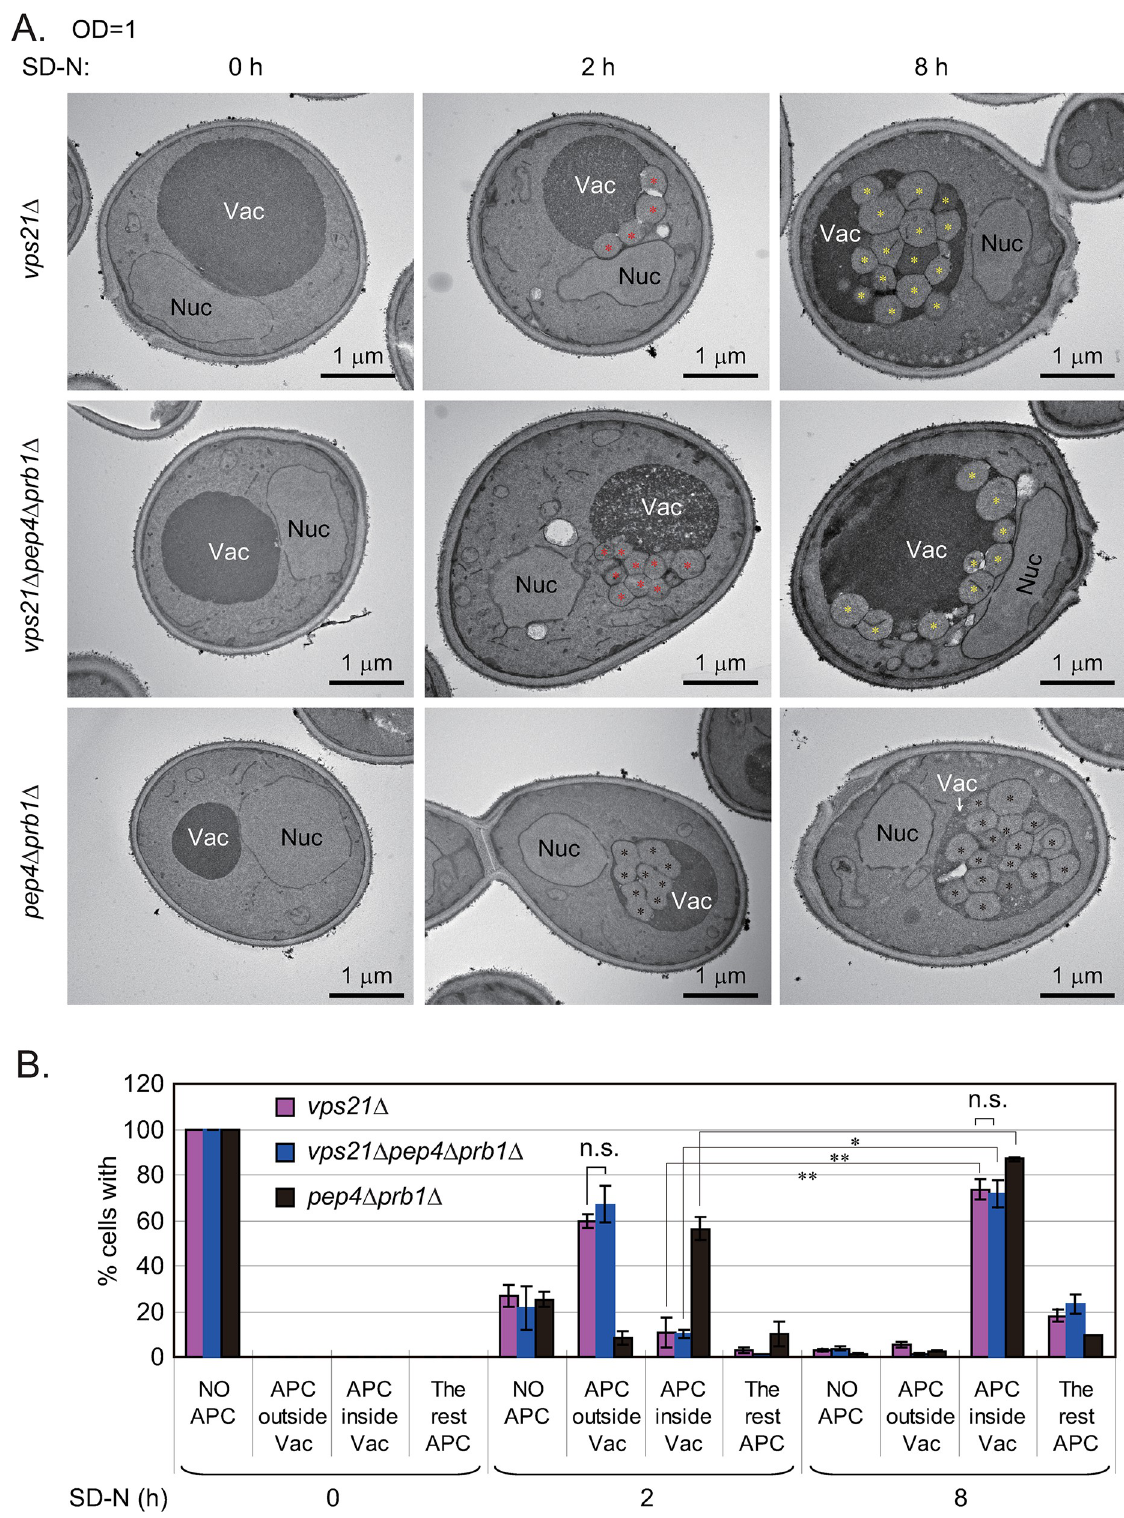
Fig 3. Ultrastructural analysis of APCs in vps21 Δ cells after representative durations of nitrogen starvation. Cells were grown and treated as described in Fig 2A but were not stained with FM4-64. A. Cells after 0, 2 or 8 h of nitrogen starvation were fixed and subjected to transmission electron microscopy (TEM) analysis as described [11]. We referred to the autophagosome-like structures outside vacuoles as